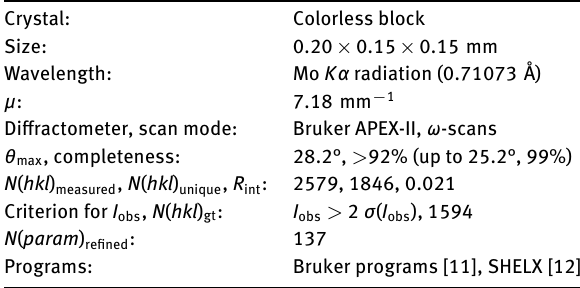
Table 2: Fractional atomic coordinates and isotropic or